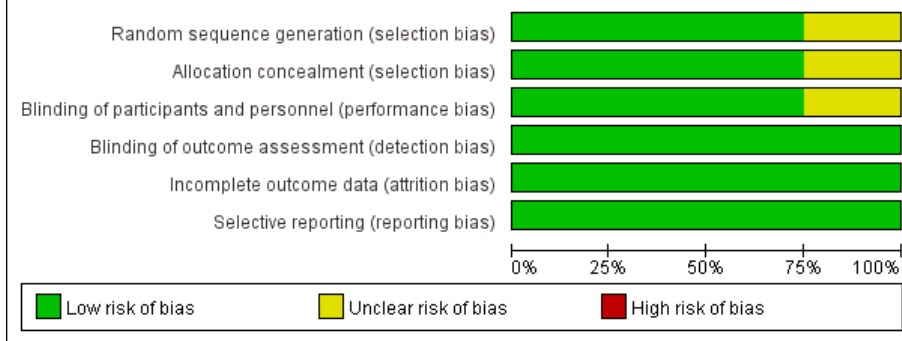
Figure 3. Risk of bias summary.